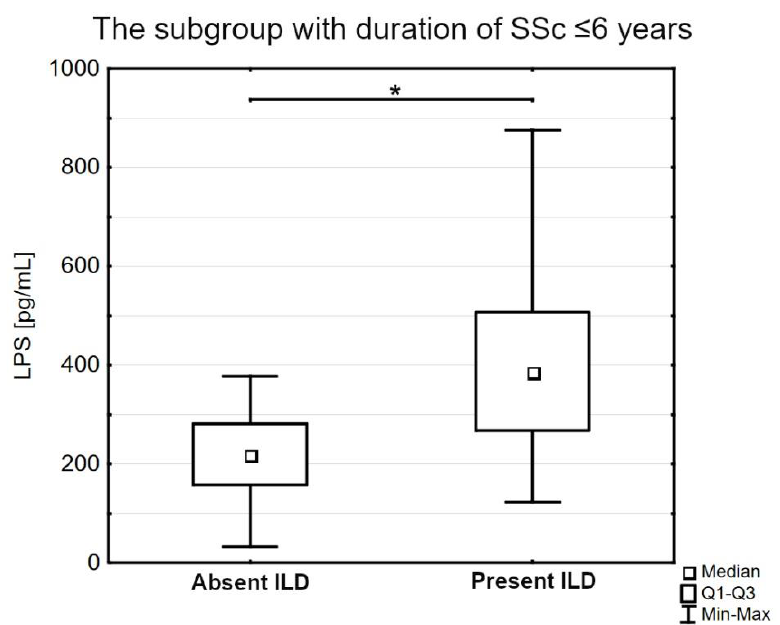
Figure 4. The serum concentration of lipopolysaccharides (LPS) in the patients’ subgroup with a shorter duration of the disease with or without concomitant interstitial lung disease (ILD); Q1 – the